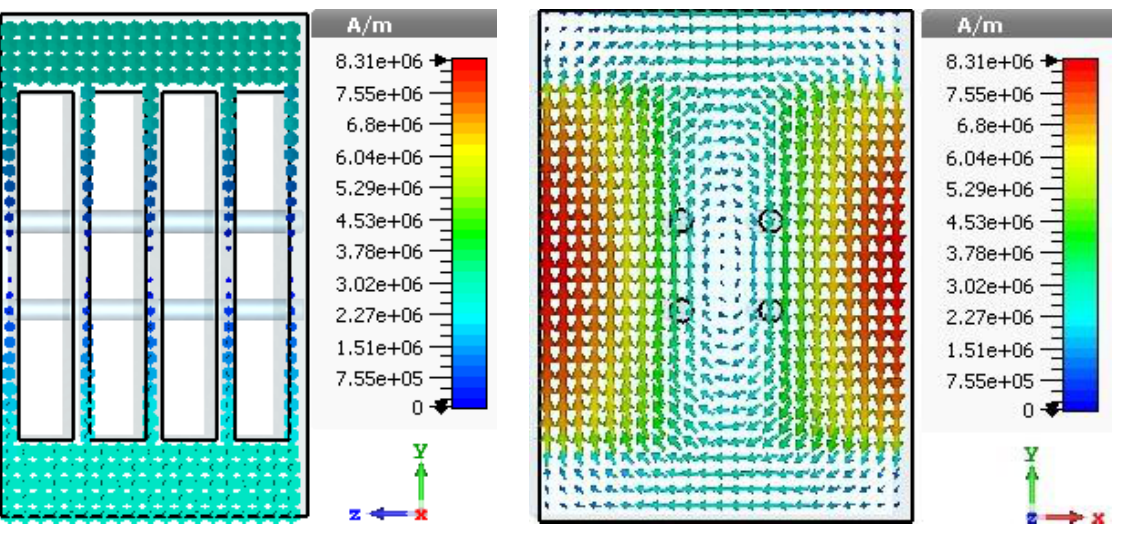
Figure 3. Electric field distribution of the 2π mode (cut -plane view) for the intermediate cavities with CST.